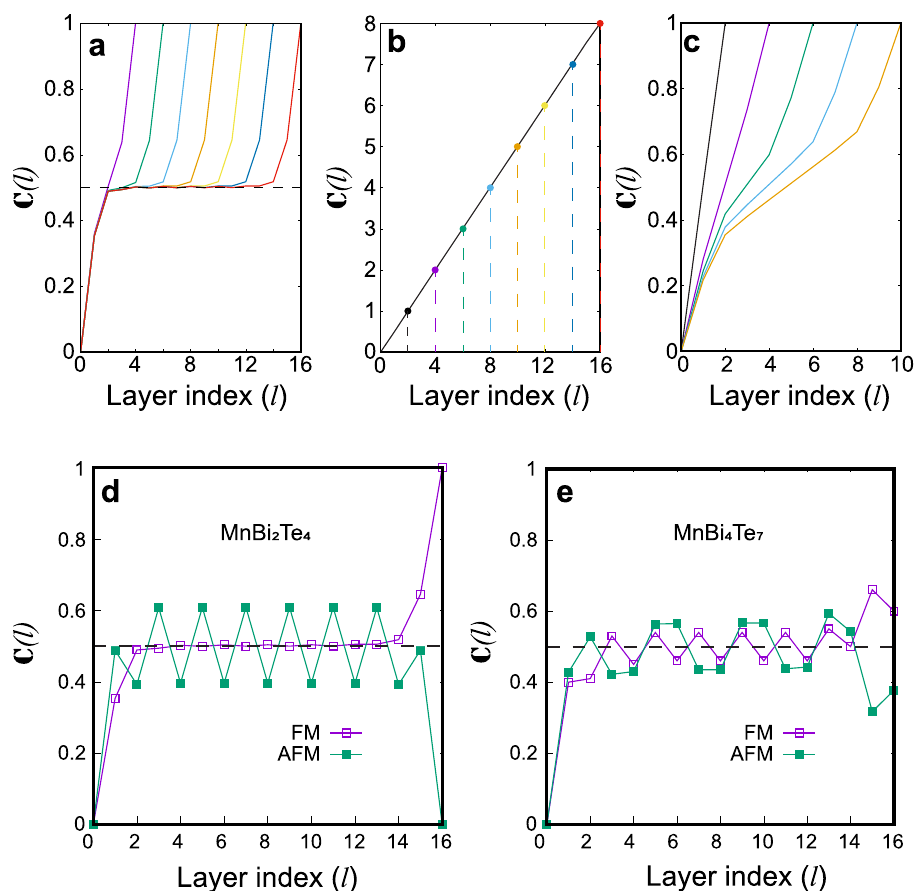
Fig. 2 Local Chern marker of various topological phases. a – c Integrated local Chern marker C l ð Þ for MnBi 2 Te 4 slabs in a axion insulator, b 3D Chern insulator, and c Weyl semimetal phases. In panel a – c , the color lines terminate at different positions, denoting the total thickness of the calculated slabs up to 16 VdW layers. d , e Integrated local Chern marker C l ð Þ as a function of layer index l for a 16-layer slab of d MnBi 2 Te 4 and e MnBi 4 Te 7